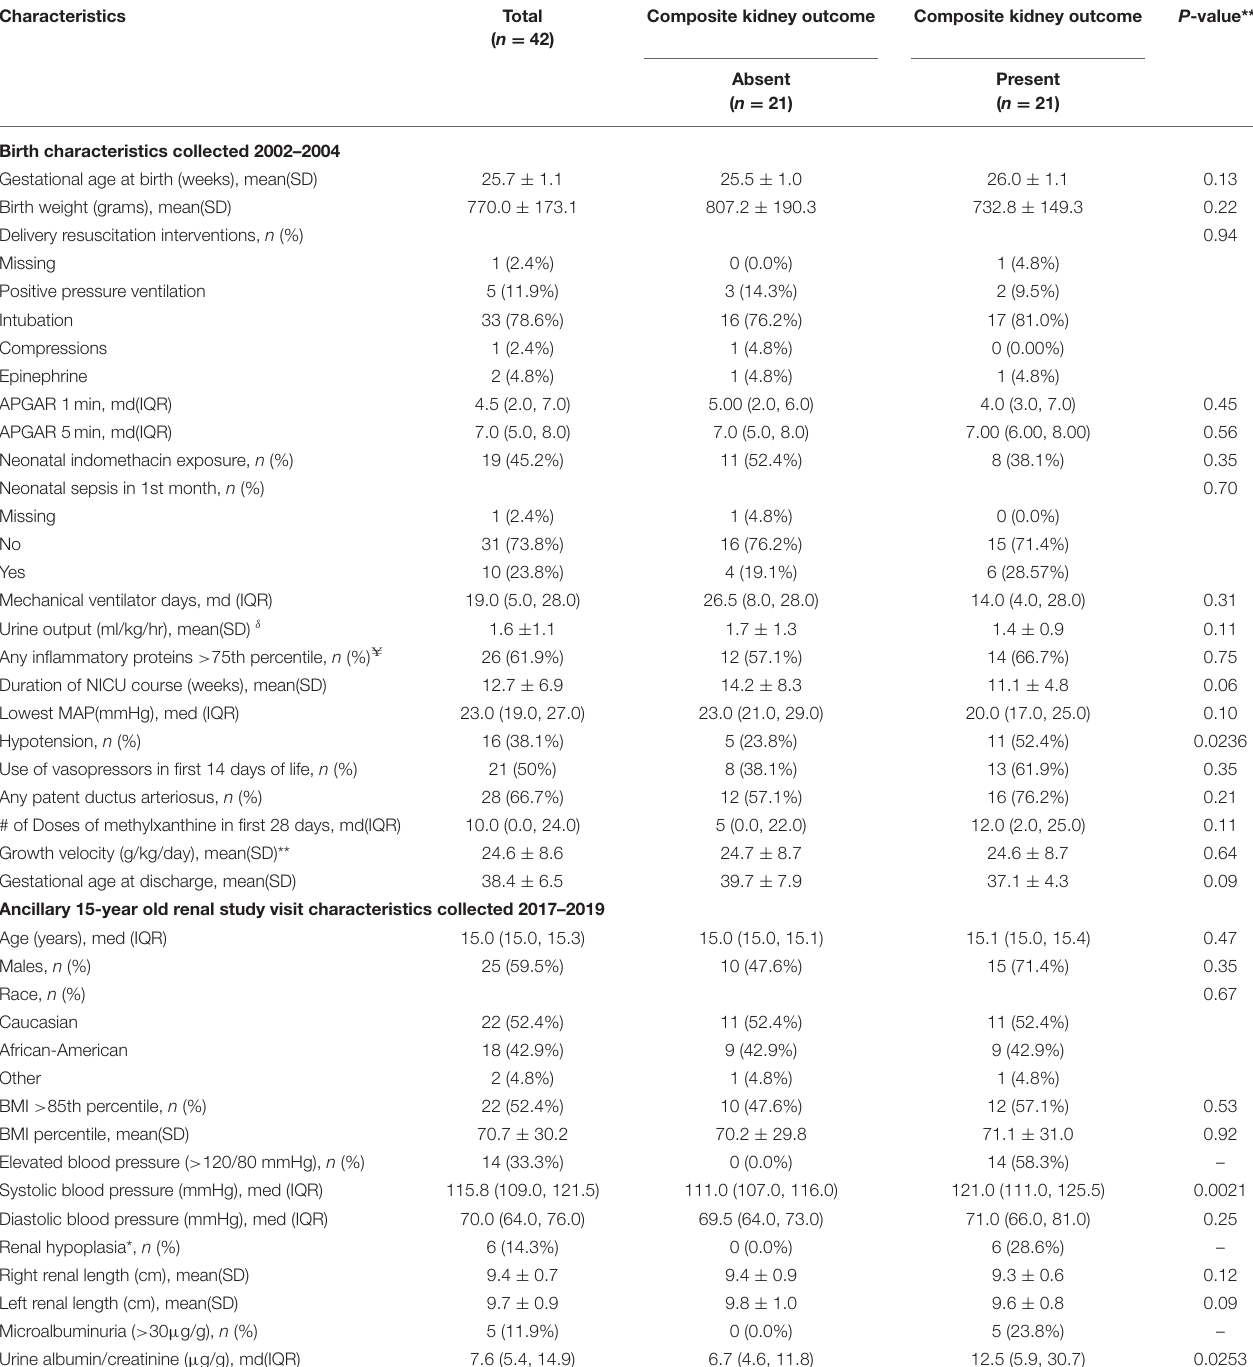
TABLE 1 | ELGAN study birth characteristics collected in 2002–2004 and ancillary kidney study visit data collected in 2017–2019 by composite kidney outcome ( microalbuminuria, elevated blood pressure, and/or abnormal kidney mass by ultrasound * ).